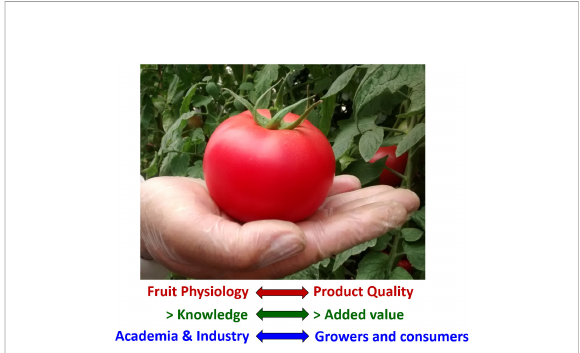
FIGURE 1 Synergistic interactions between the academia, industry, growers, and consumers will guide future efforts towards improving fruit productivity, fl avor, and nutritional